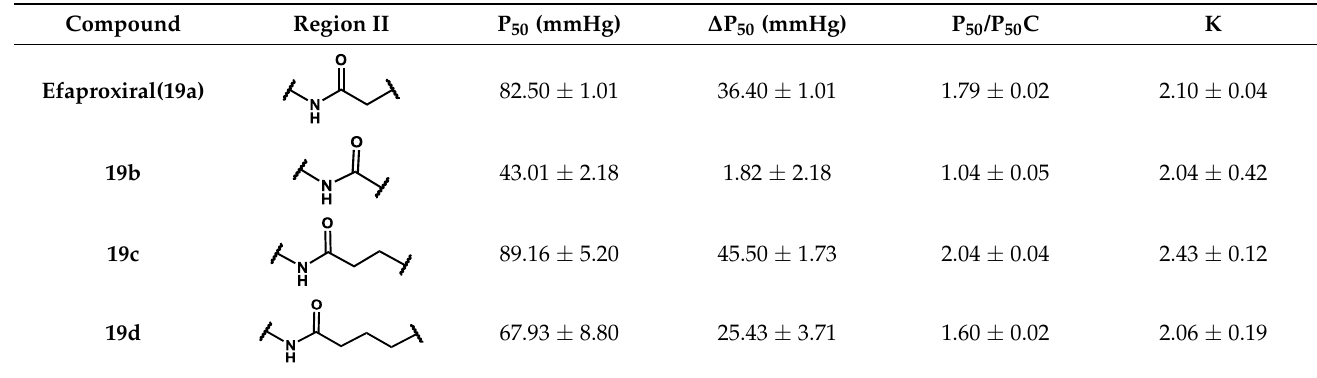
Table 2. Results of in vitro red blood cell studies.